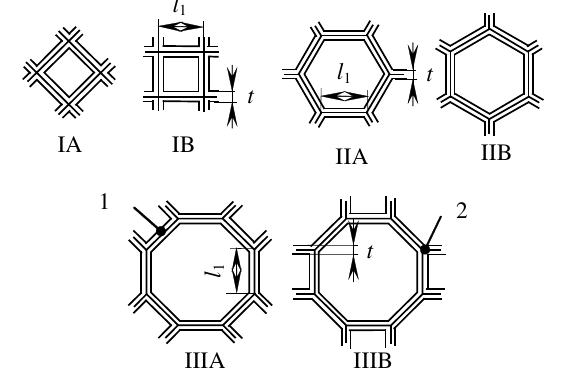
Fig 1. Cells of foamed materials; 1 – edge, 2 – vertex, l 1 – length of edge, t – thickness of